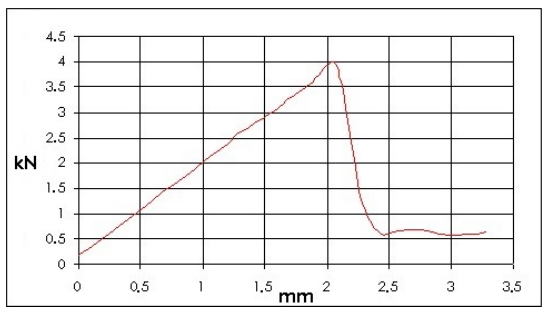
Figure 10. Shear force vs. elongation of a 41 mm Mylar belt bonded to the tyre tread. The test was performed on an Instron machine.